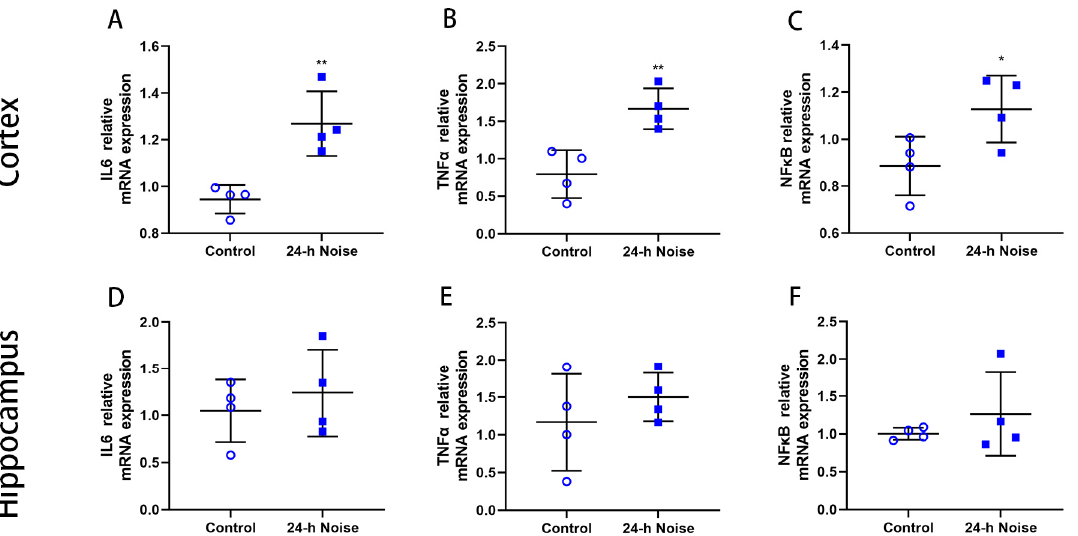
Figure 2. Around-the-clock noise (24 h/day) exposure is associated with neuroinflammation in the cortex and hippocampus of rats. ( A – F ) The mRNA expression of IL6 , TNF α , and NF κ B in the cortex and hippocampus ( n = 4 per group). * p < 0.05, ** p < 0.01.